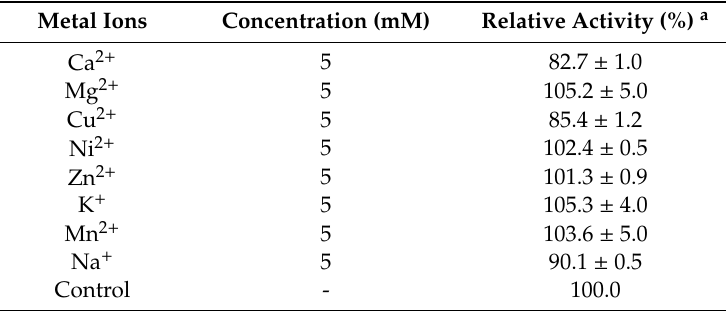
Table 3. Metal ion e ff ects.